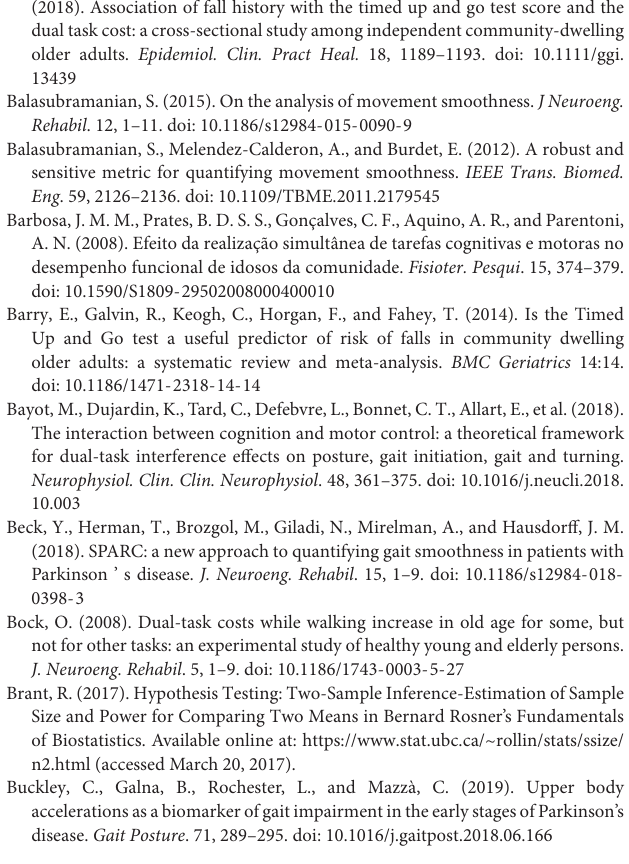
FIGURE S2 | Statistical plan. This step-by-step plan illustrates the statistical choices and decisions. FIGURE S3 | Fallers displayed reduced smoothness while standing from a chair or turning and sitting on the chair, but the latter displayed absence of task effect. (a,b) Fallers showed reduced smoothness (SPARC) while transitioning from the sitting to the standing position during the dual task. (c,d) The final TUG transition “turn-to-sit” was not affected by the task. (e) The representative spectral profile of a participant performing the “turn-to-sit” phase of the TUG task under single and dual task conditions. Note the mild SPARC values and the lack of noticeable difference between single and dual task. V: ventral; ML: mediolateral; AP: